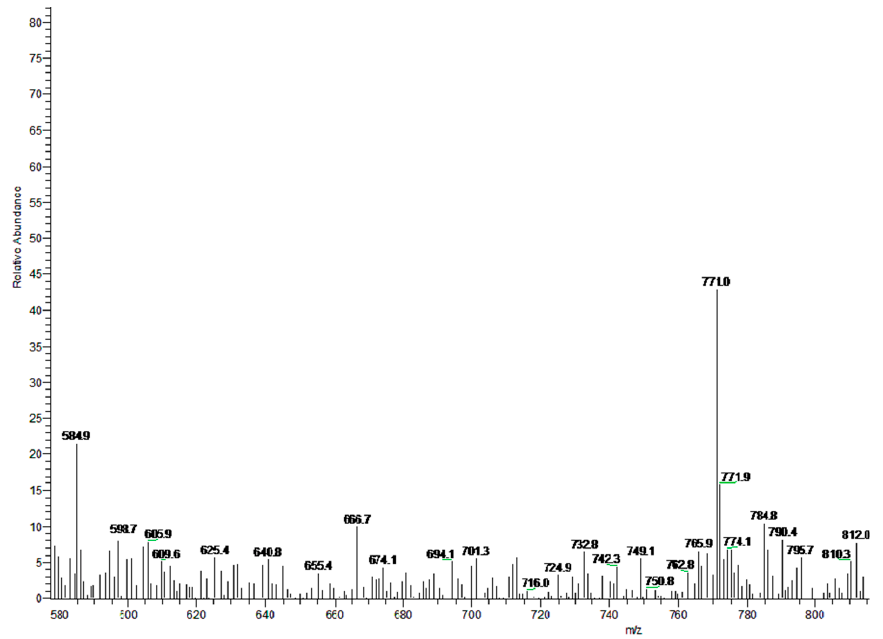
Figure 5. MSI-MS spectrum of HTH.